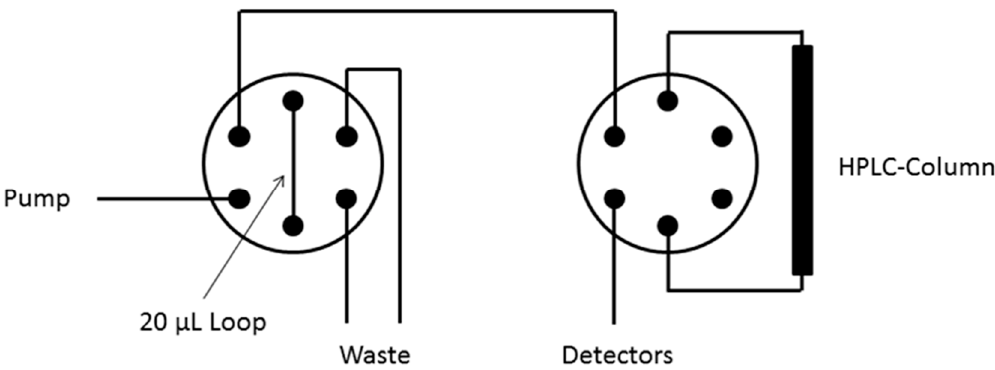
Figure 5. Arrangement of HPLC valves (analytical HPLC).